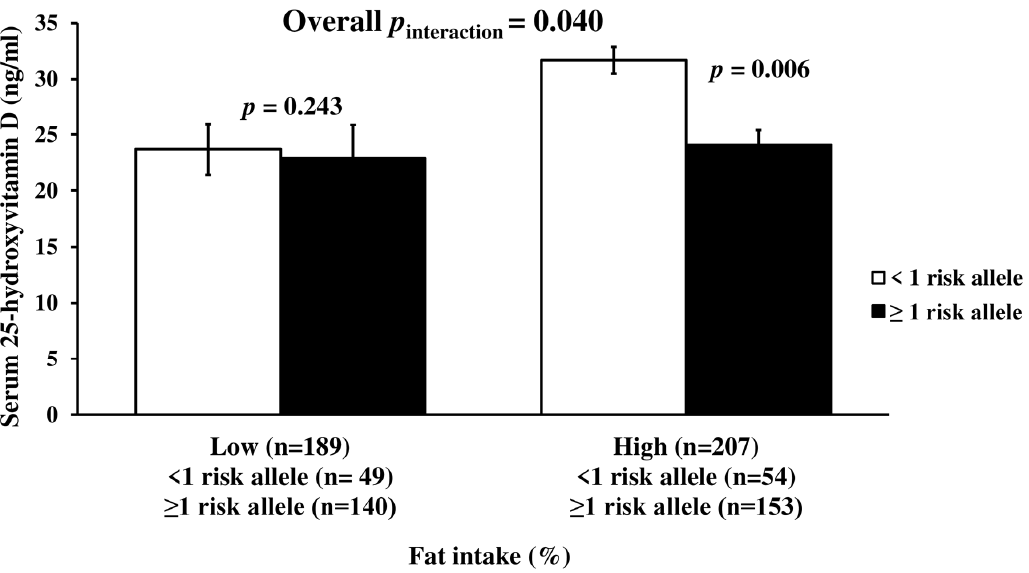
Figure 2. Interaction between metabolic-GRS and fat intake (%) on serum 25(OH)D